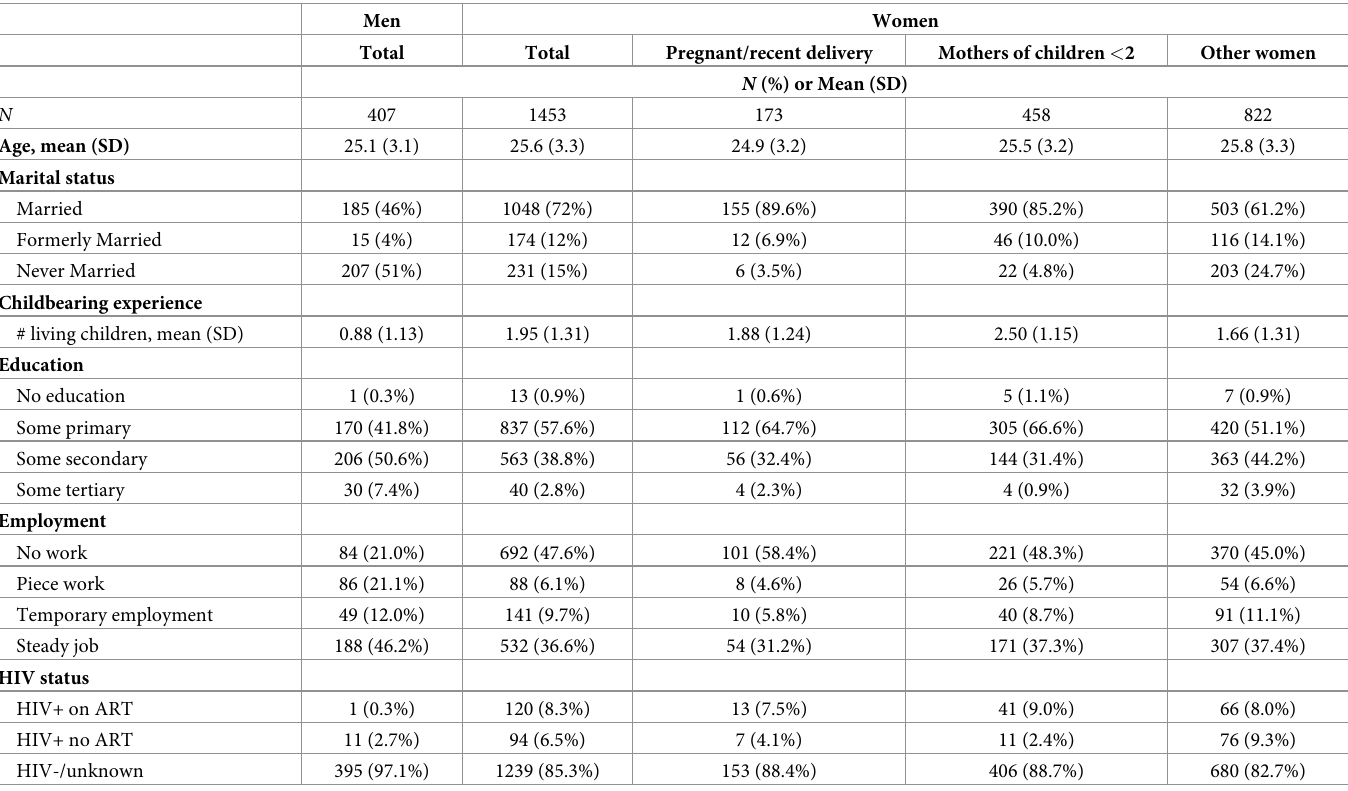
Table 2. Sociodemographic characteristics of TLT sample in 2015 by